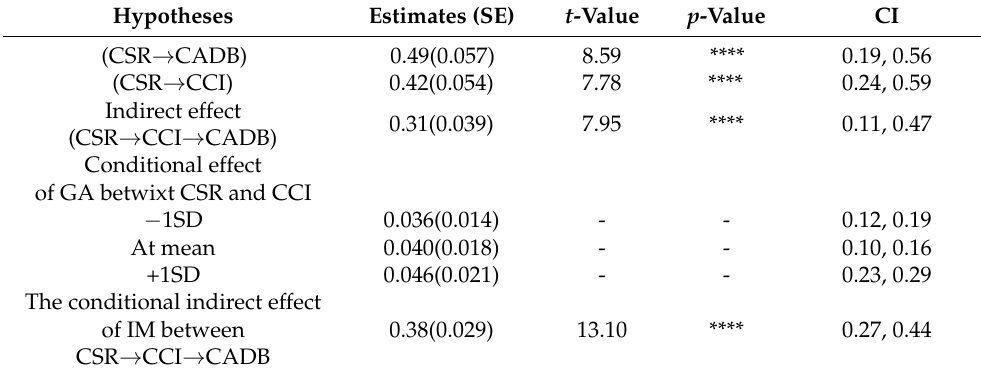
Table 7. Structural